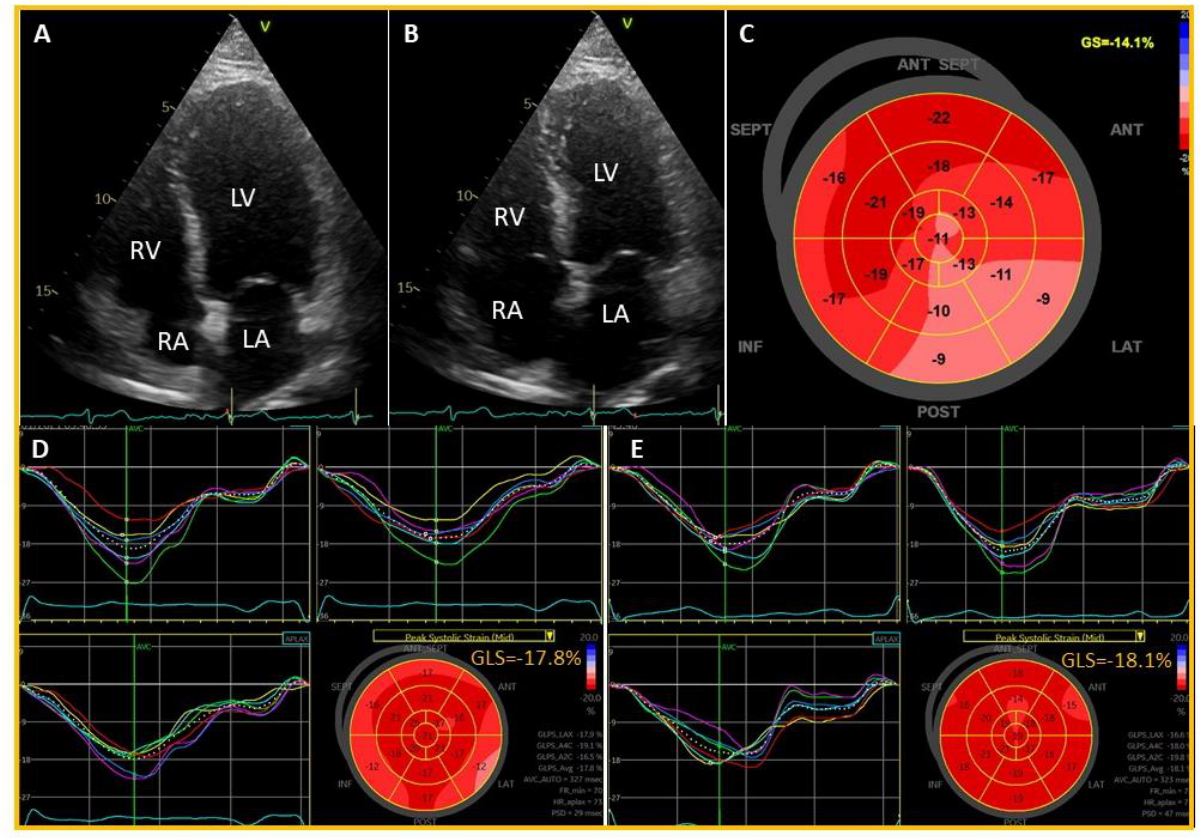
Figure 2. Echocardiographic images of the heart on admission ( A – C ), at discharge ( D ) and at 6-weeks follow-up ( E ). ( A ) demonstrates end-diastolic and ( B ) end-systolic frames on apical four chamber views. The distal septal segments towards the apex are hypokinetic and slightly dilated ( A ) and shows little motion toward the mid-cavity during end-systole ( B ). The Bulls eye plot shows reduced (less negative) strain values in lateral and posterior walls from basal to apical segments ( C ) with an average global longitudinal strain (GLS) of −14.1%. ( D ) displays improvement of GLS to −17.8% on discharge but still some impaired strain value in a basal segment of the lateral wall. Strain values were further improved to −18.1% at 6-weeks follow-up ( E ), although there was some post-systolic shortening (left upper and lower panels). LA, left atrium; LV, left ventricle; RA, right atrium; RV, right